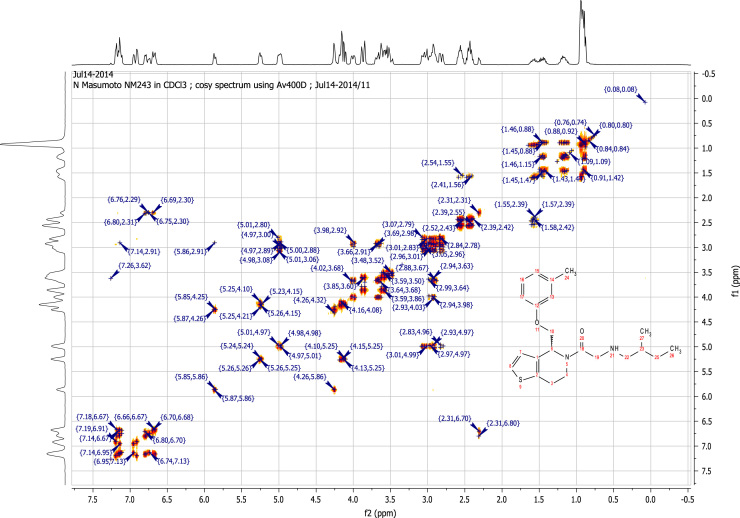
2D COSY (400 MHz,
CDCl3) of RU-SKI 43
(9b).